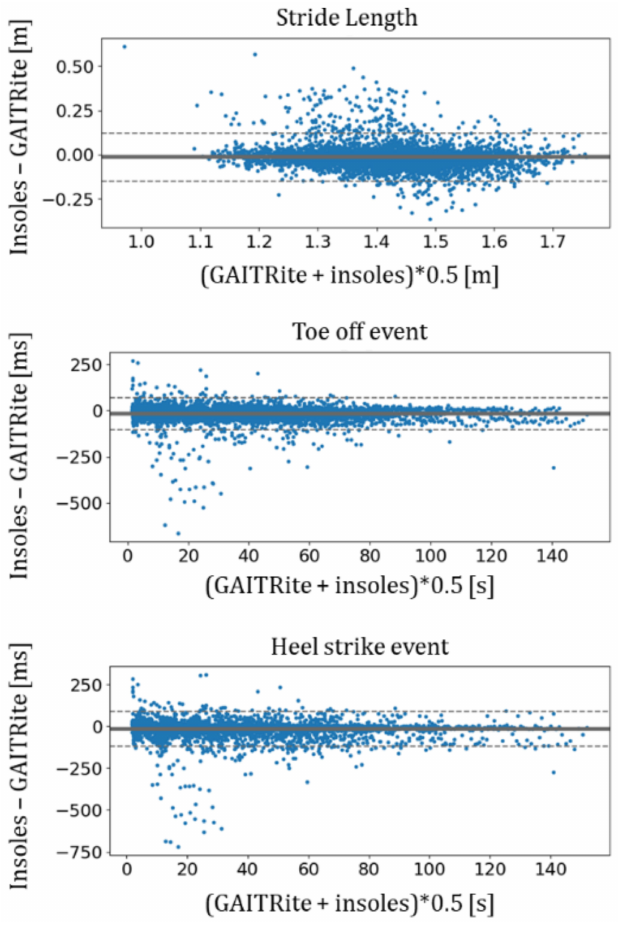
Figure 2. Bland–Altman plots of insole-based parameters including HS, TO and stride length. The solid line is the bias, and the dashed lines are the lower and upper limits of the 95th CI of